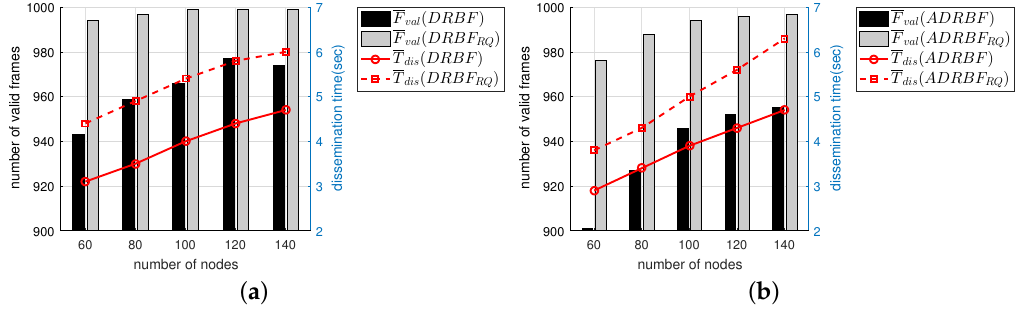
Figure 13. Perfomance comparions of ( a ) DRBF and DRBF RQ ( b ) ADRBF and ADRBF RQ